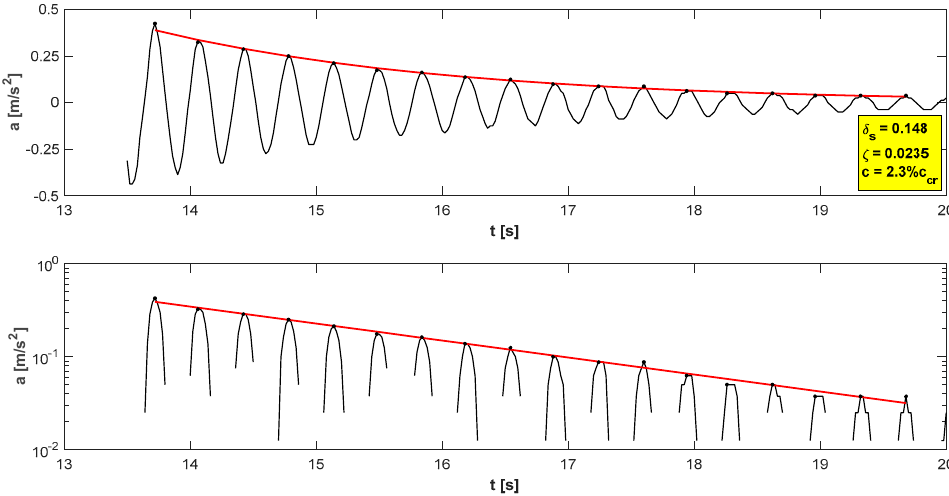
Figure 29. Determination of the damping coefficient.